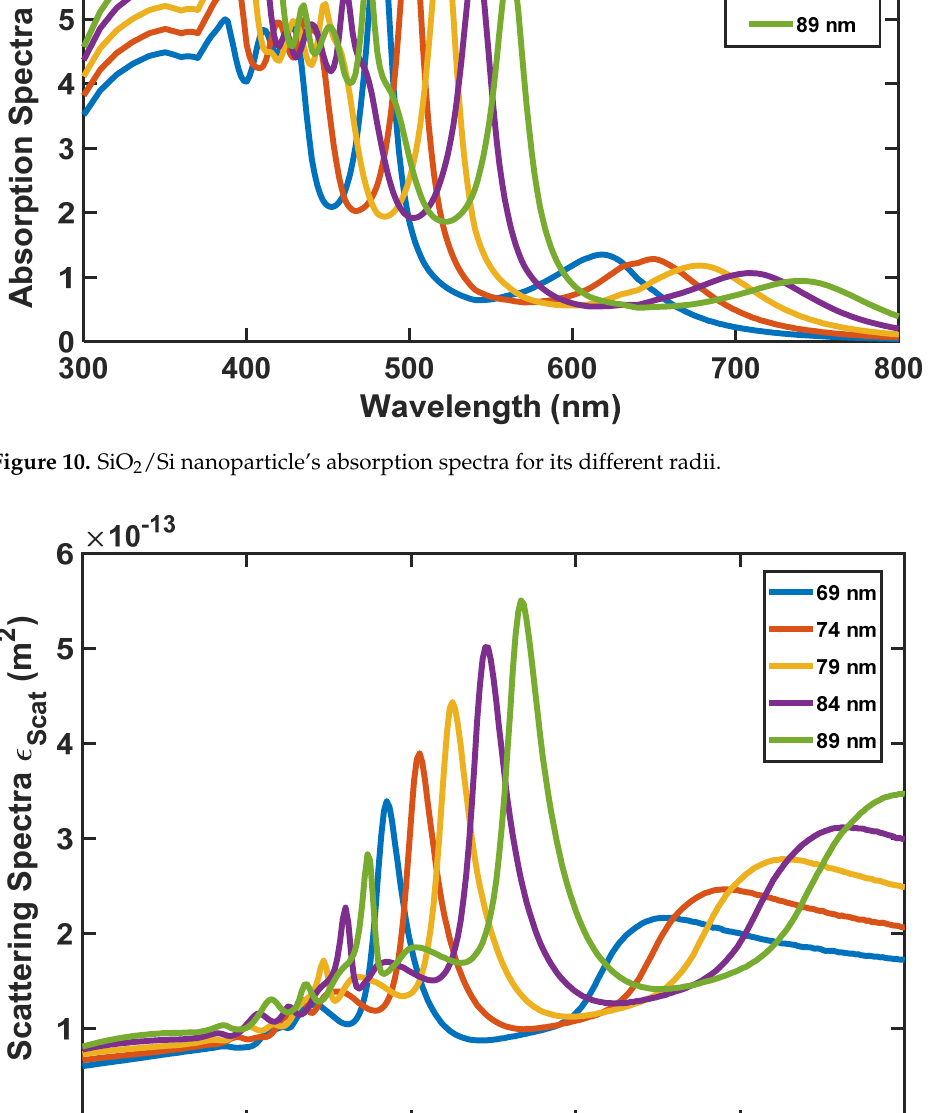
Figure 11. SiO 2 /Si nanoparticle’s scattering spectra for its different radii.